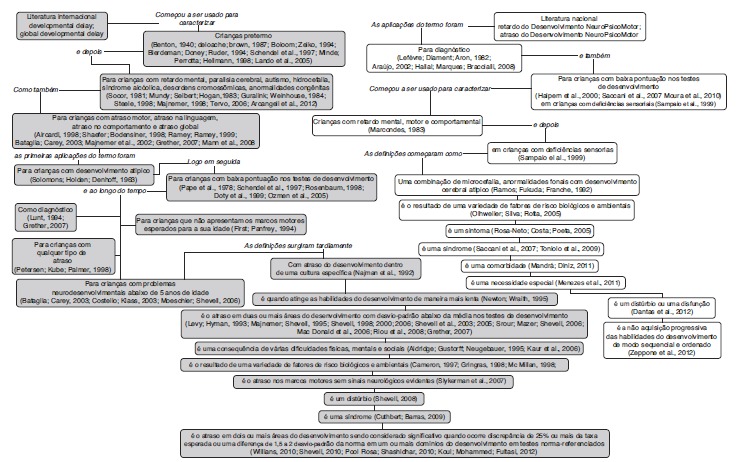
Mapa conceitual do termo atraso do Desenvolvimento
Neuropsicomotor.